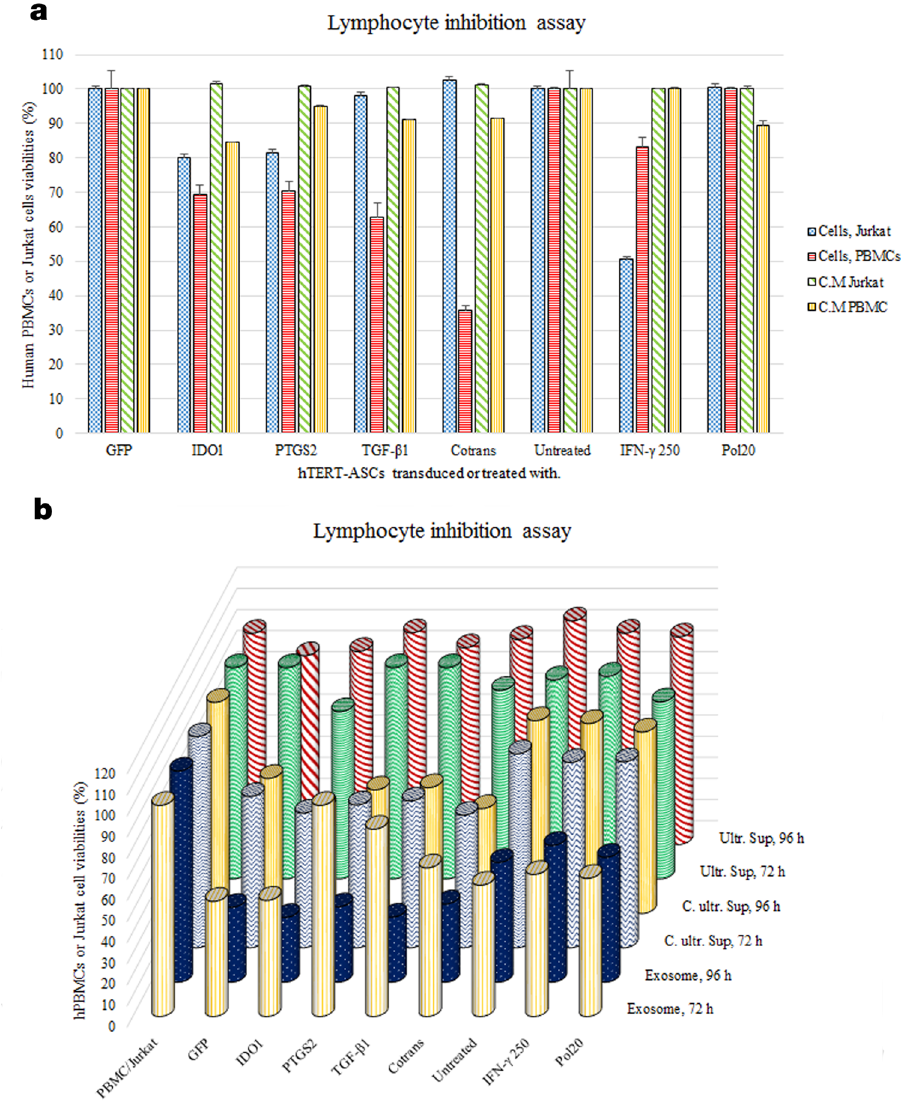
Figure 6. Lymphocyte inhibition assay. ( a ) Lymphocyte inhibition assay was performed following three days of co-culture experiments between PBMCs or Jurkat cells and hTERT-MSCs transduced with different viral particles or treated with interferon gamma (250 U/ml) or poly(I:C) (20 µg/ml). As demonstrated, some experiments were performed for 4-day conditioned media of the cells. Relative ODs (450 nm) in each group were read following 4 h incubation of Orangu dye with hPBMCs by an ELISA reader (Awareness Technology, USA). Data are represented as mean of viabilities ± SEM. ( b ) Functional analysis of cell-free products from the hTERT-MSCs. Lymphocyte inhibition assay experiments were performed for exosomes, PEG-concentrated ultracentrifuge supernatants and ultracentrifuge supernatants without any modification in the permanent presence of 3 µg/ml PHA as proliferation stimulant. 72 h and 96 h co-cultures were applied for functional analysis based on the detection of viable cells via sensitive Orangu dye. All experiments were performed against human PBMCs except for the ultracentrifuge supernatant which was performed against Jurkat cells. During all co-culture experiments we applied the hPBMCs/Jurkat cells to MSCs ratio as 10:1. For cell-free products 100 µg of the products were added to the culture media of hPBMCs/Jurkat cells (10 6 cells/well). Data represent mean of three independent experiments. Relative ODs (450 nm) in each group were read by an ELISA reader (Awareness Technology, USA) following 4 h